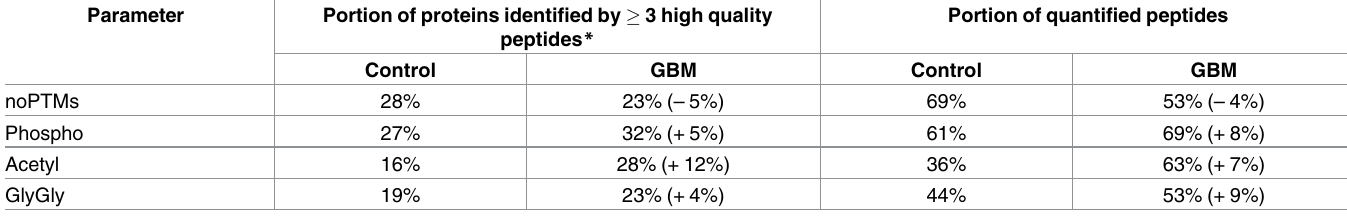
Table 1. Number of identified proteins/peptides due to PTM-sensitive MS/MS search for control and GBM plasma samples. Parameter Portion of proteins identified by (cid:21) 3 high quality Portion of quantified peptides *